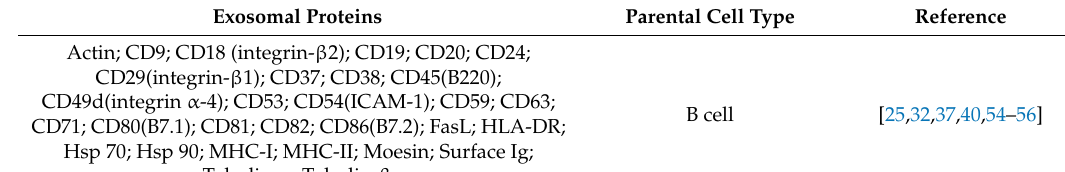
Table 1. Exosomal proteins of human